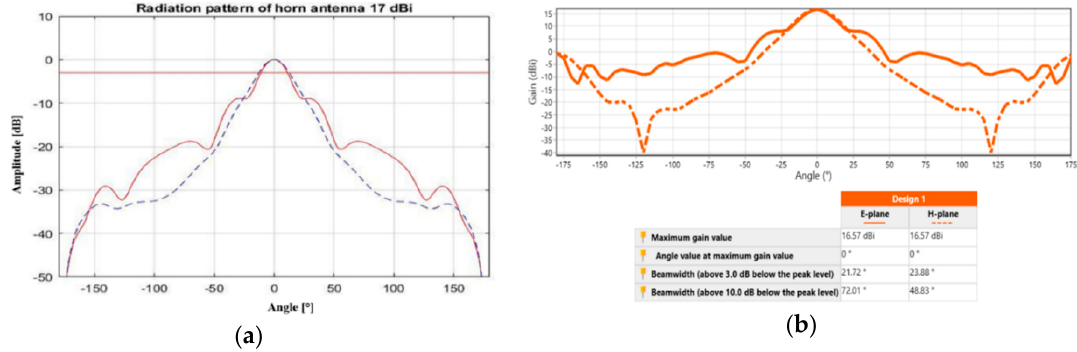
Figure 10. Emissiondiagramforanantennawithagainof17dBi. ( a )Matlab; ( b )AntennaMagussoftware. Figure 10. Emission diagram for an antenna with a gain of 17 dBi. ( a ) Matlab; ( b ) Antenna Magus software.